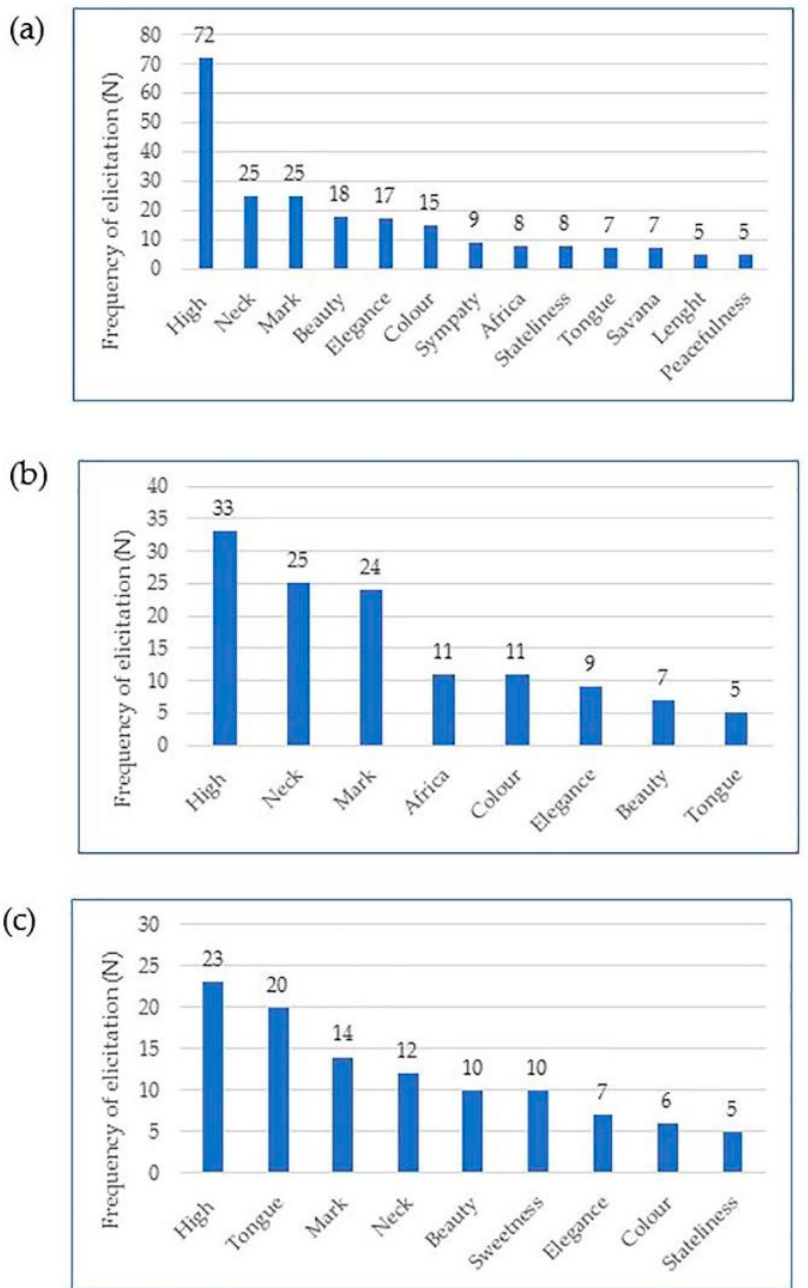
Figure 3. Frequency of elicitation of words in general visitors (genQ) ( a ), pre-interaction version (preQ) ( b ), and post-interaction version (postQ) ( c ). In the three graphics, all the words (after lemmatization) that were mentioned by five respondents or more are